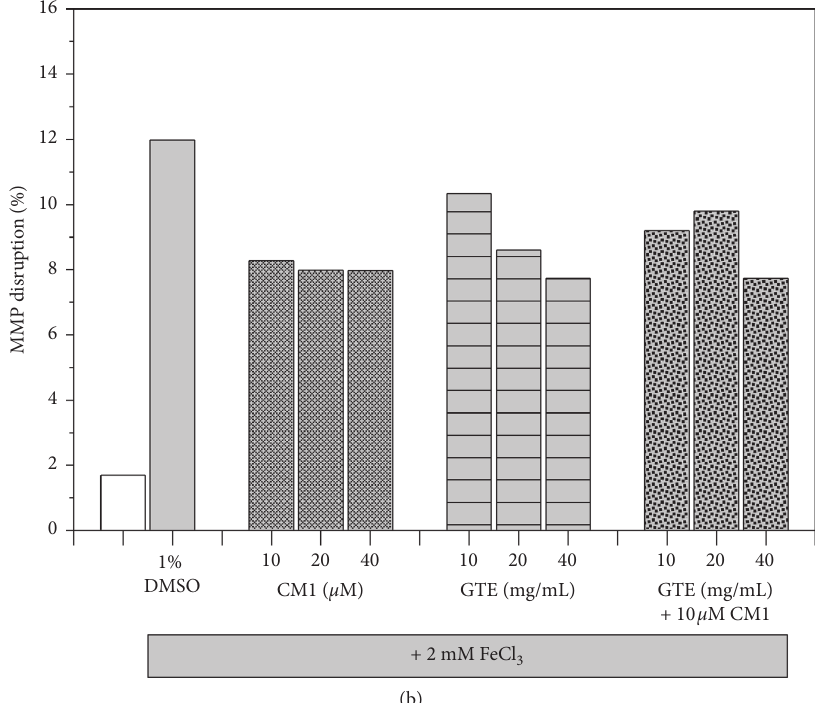
Figure 2: Mitochondrial membrane disruption in SH-SY5Y cells after being exposed to treatments with or without 2mM FeCl then treated with 1% DMSO, CM1 (10–40 μ M), GTE (10, 20, and 40mg/mL equivalent to 5.24, 10.48, and 20.96 μ M EGCG, respectively) and a combination of CM1 and GTE for 24 h. Data are expressed as dot-plot graphs (a) and histogram of triplicate experiments (b).